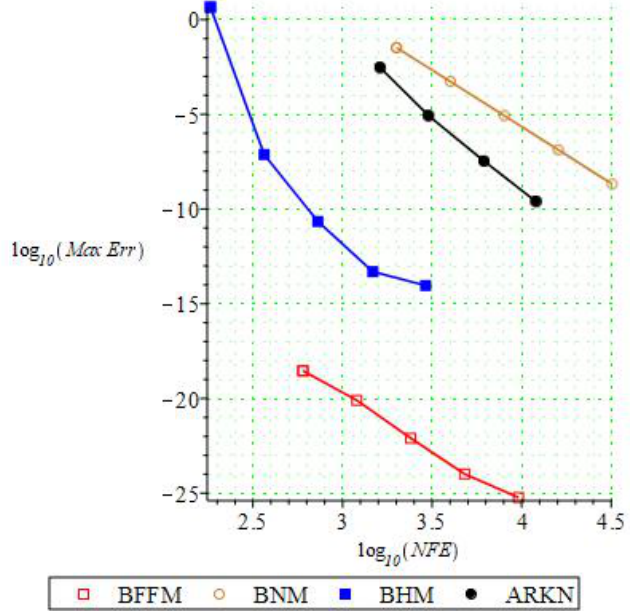
Figure 7. Efficiency Curves for Example 5.